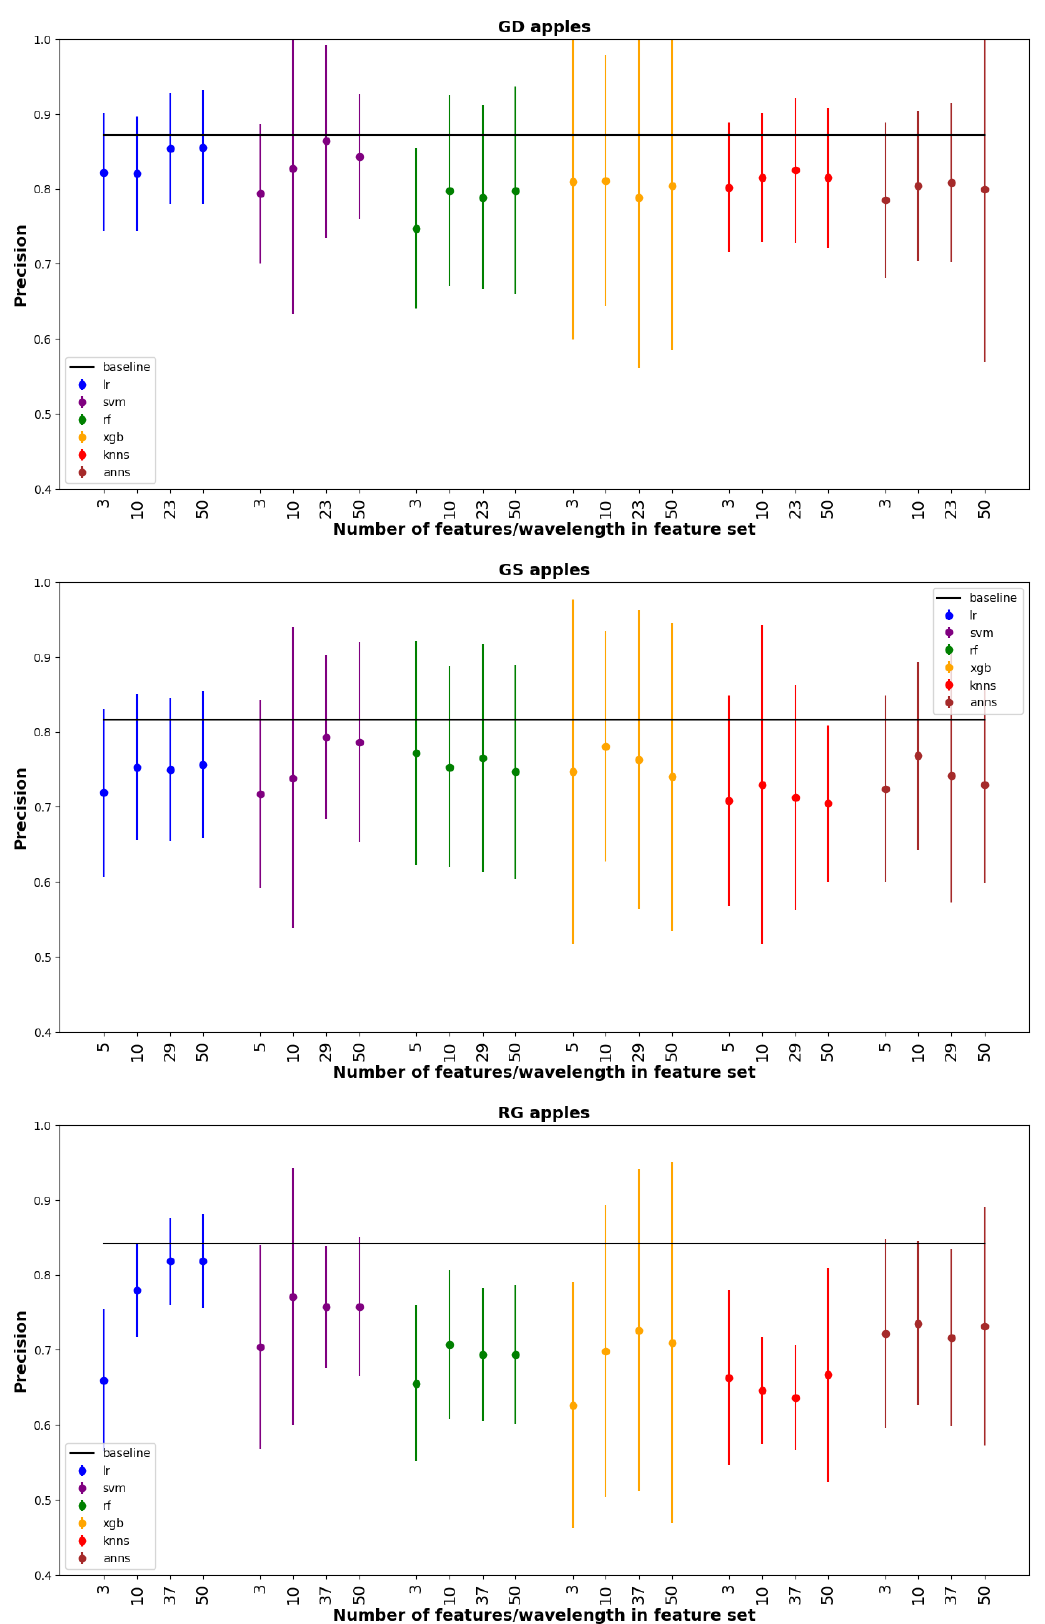
Figure 6. Plot of precision for all models using and all selected feature subsets, on test data with a comparison to the baseline model (horizontal line). The vertical lines represent error